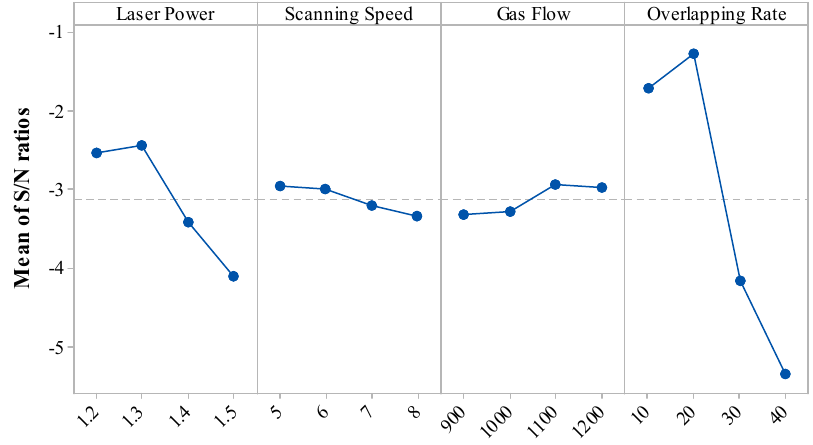
Figure 3. Main e ff ects plot for the S / N analysis of flatness Figure 3. Main effects plot for the S / N analysis of flatness ratio.